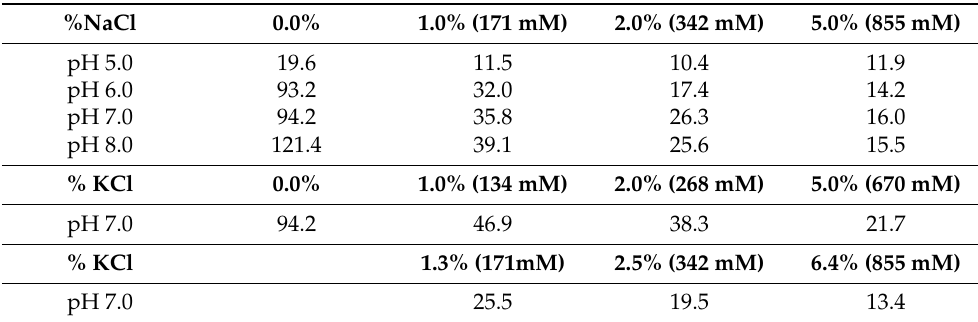
Table 2. Critical micelle concentration values of RL solutions under different pH and salt